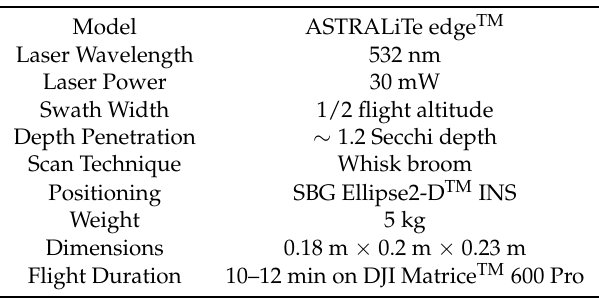
Table 2. Specifications of small Unmanned Aerial System (sUAS) bathymetric